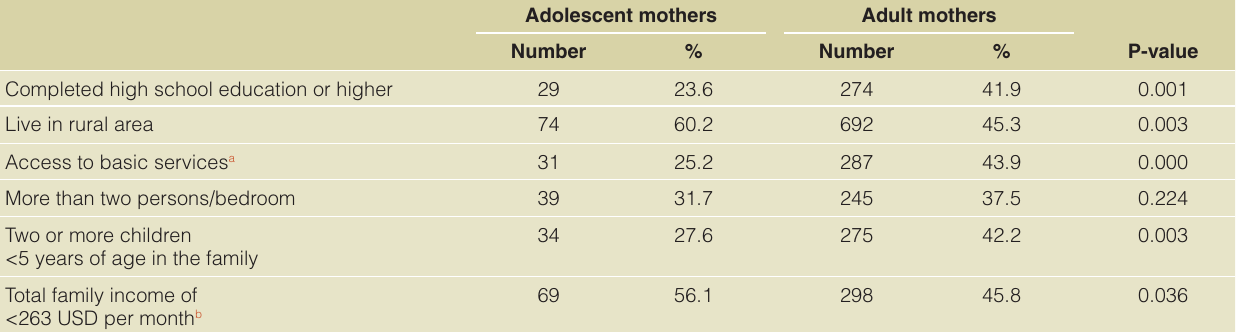
Table 2. Basic social and economical characteristics of the mothers and of their living